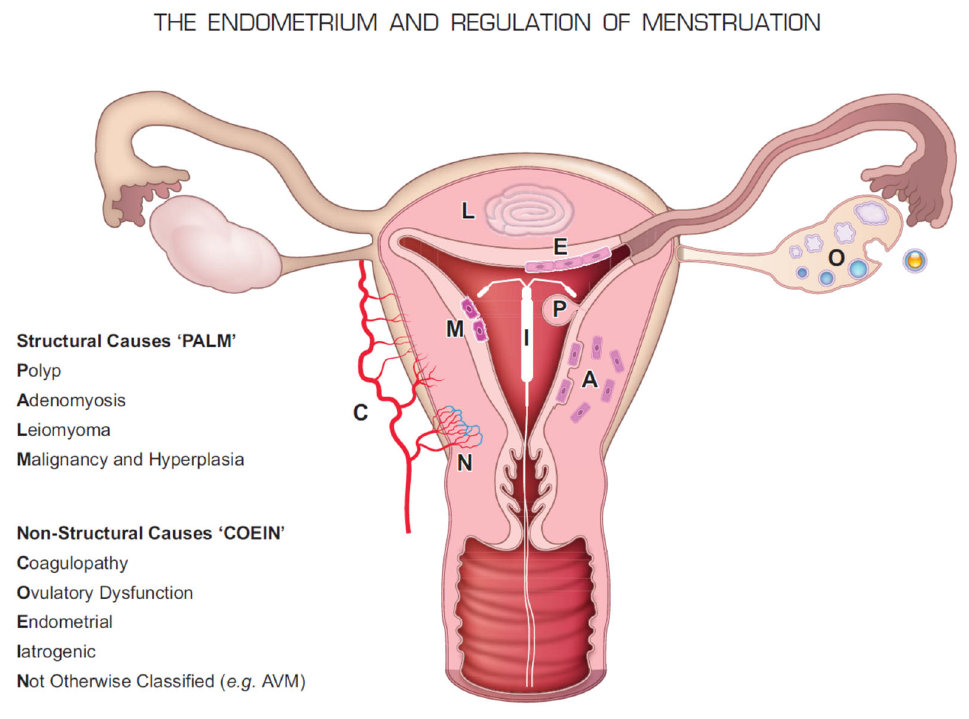
Figure 1. Illustration of the PALM-COEN classification system for abnormal uterine bleeding. From Critchley et al. (2020) [1] (reproduced with permission).